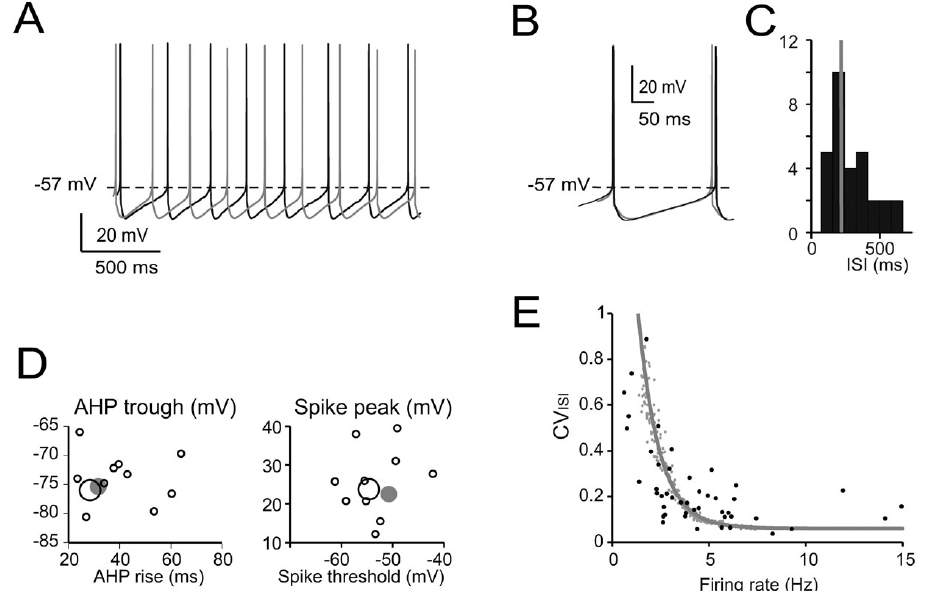
Figure 2. Pacemaking . ( A ) Pacemaker activity during Golgi cell WCR (black) and in the model (gray). ( B ) Enlarged view of interspike interval (ISI) taken from A. The model (leakage reversal potential (cid:1) 62mV) faithfully follows the membrane potential of this specific Golgi cell. ( C ) Distribution of the ISI of spontaneously firing Golgi cells (mean of 20–50 ISI per cell; n ¼ 32) during WCR. Note that the ISI in the model (gray bar) falls on the mode of the experimental data distribution. ( D ) Relationships among ISI parameters. Note that the model data points (large gray dots) fall within the distribution of spike amplitude versus spike threshold and within the distribution of AHP trough versus AHP rise-time measured experimentally (black circles, the larger ones corresponding to the trace in A–B). The model did not significantly differ from the data (p > 0.12, t-test). ( E ) The experimental relationship between CV ISI and firing rate (n ¼ 47 WCR) showed a negative correlation. The model was injected with a noisy current (32pA SD, see Methods) and the spontaneous frequency was varied among the values observed during WCRs by changing the leakage reversal potential from (cid:1) 67 to (cid:1) 55mV. Simulations (gray line) show that the model could appropriately fit the experimental measurements